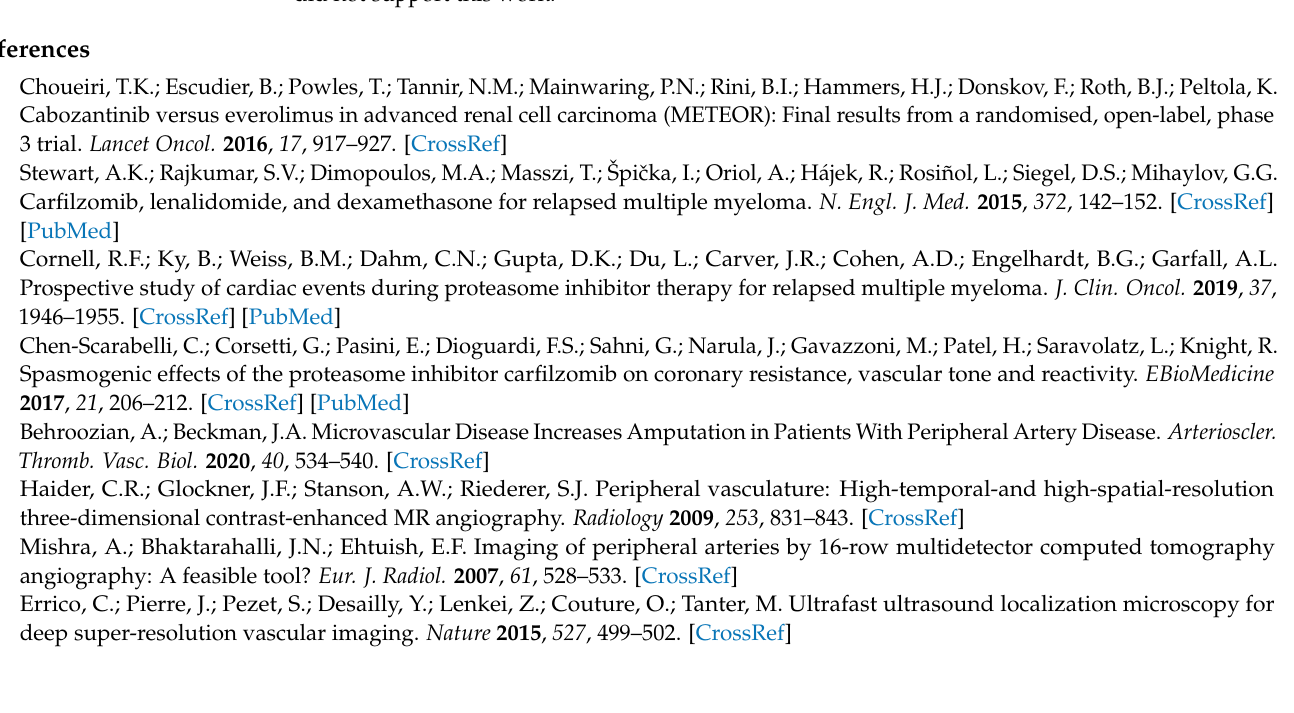
MAP images of 9 ROIs during 10 h after PBS injection. Figure S9: Quantitative evaluation of 9 ROIs within 10 h after PBS